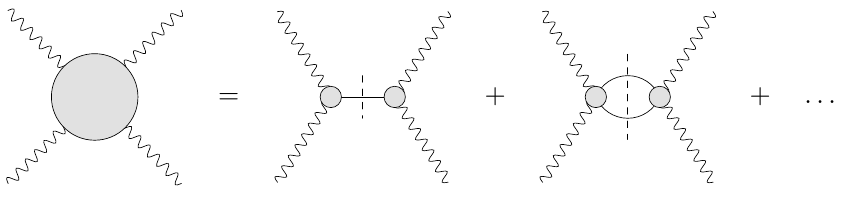
Figure 4. Intermediate states in the direct channel: pion pole and two-pion